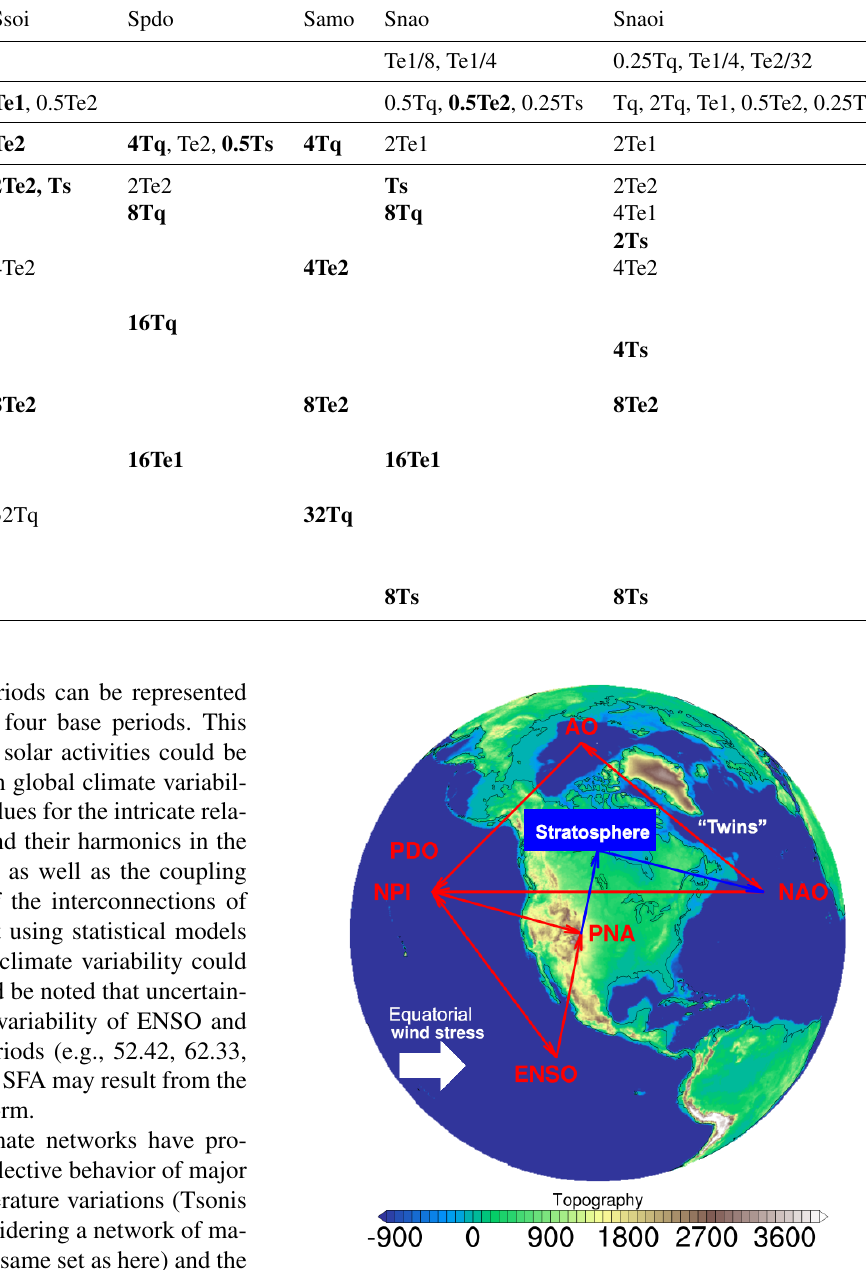
Figure 4. The 3-D super-loop NAO → PDO → ENSO → PNA → stratosphere → NAO, which may capture the essence of low-frequency variability in the Northern